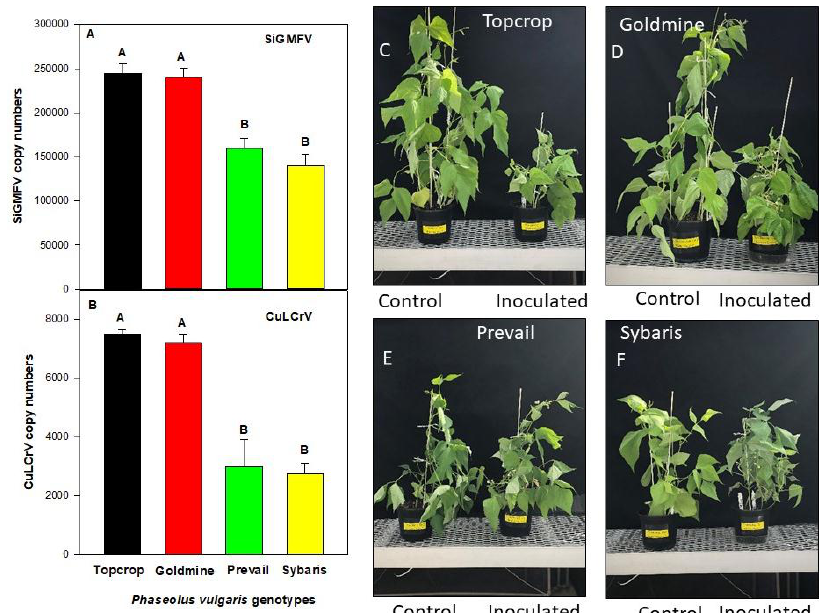
Figure 2. Accumulation of CuLCrV and SiGMFV and leaf crumple severity in P. vulgaris genotypes in greenhouse (susceptible vs. resistant; identified in field screen). Data points represent the mean copy numbers of SiGMFV ( A ) and CuLCrV ( B ) in two susceptible (Top crop and Gold mine) and two resistant genotypes (Prevail and Sybaris) in two independent experiments. Bars indicate standard error of the mean. Means with similar letter are not significantly different according to least significant difference (LSD) at p = 0.05 level. Response of two susceptible [Top crop ( C ) and Gold mine ( D )] and two resistant [Prevail ( E ) and Sybaris ( F )] genotypes to mixed infection (CuLCrV and SiGMFV). The effect of genotypes on disease severity upon exposure to viruliferous whiteflies (CuLCrV and SIGMFV) was significant ( p = 0.001). At 30 DPI, disease severity